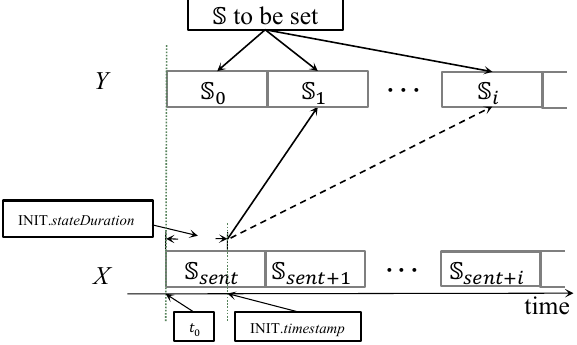
Figure 4. The transmission of INIT message. S i indicates the next i th state after S 0 , and S sent + i denotes the i th state after S sent